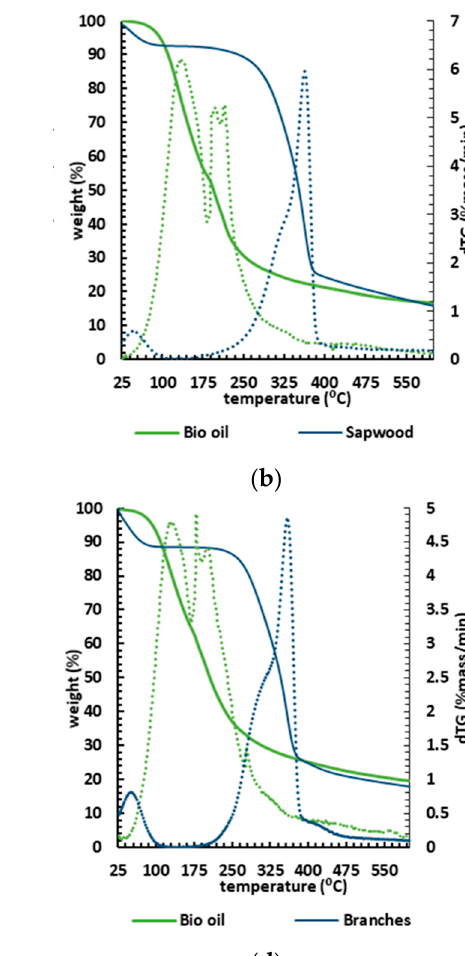
( e ) Figure 6. TGA (solid lines) and DTG (dashed lines) curves for the different biomasses: ( a ) bark; ( b ) sapwood; ( c ) heartwood; ( d ) branches; ( e ) pinewood, and their corresponding bio-oils. Considering the thermogravimetric analysis as a proxy to determine the biopolymeric composition in terms of cellulose, hemicellulose, and lignin [75], the TGA biomass analysis showed that the TGA curves were very similar, proving low variability in chemical composition within the tested samples.